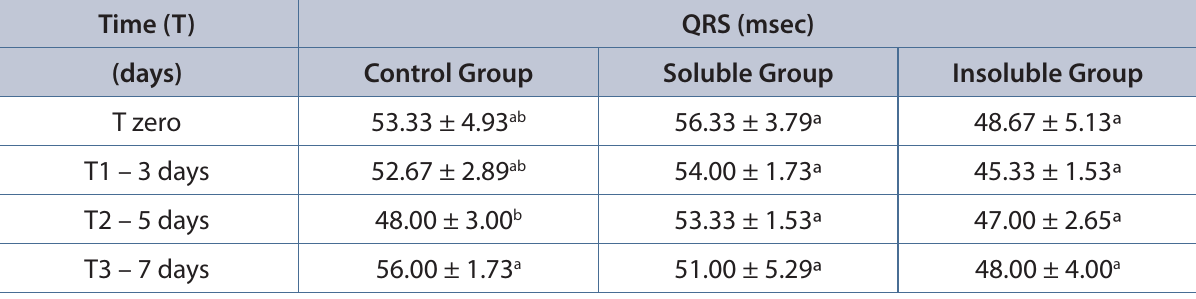
Table 6. QRS complex mean duration in rabbits submitted to gavage with ultra-pure water (CG), water- soluble A. rigida extract (SG) and water-insoluble A. rigida extract (IG) at different times